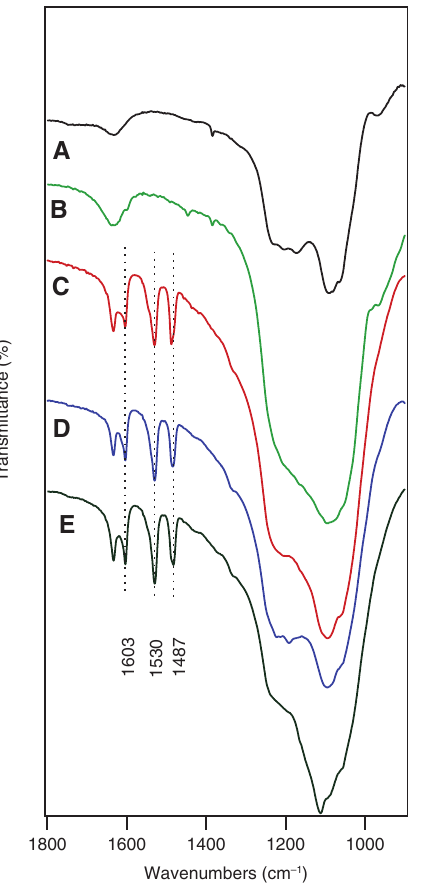
H, (B) pyridine adsorbed Figure 4: FT-IR spectra of (A) FSM-16-SO 3 FSM-16, and (C) FSM-16-SO H at ambient temperature; pyridine- 3 adsorbed FSM-16-SO H heated at (D) 100 ° C and (E) 200 ° C. Figure 5: Potentiometric titration of (A) FSM-16 and (B) FSM-16-SO 3